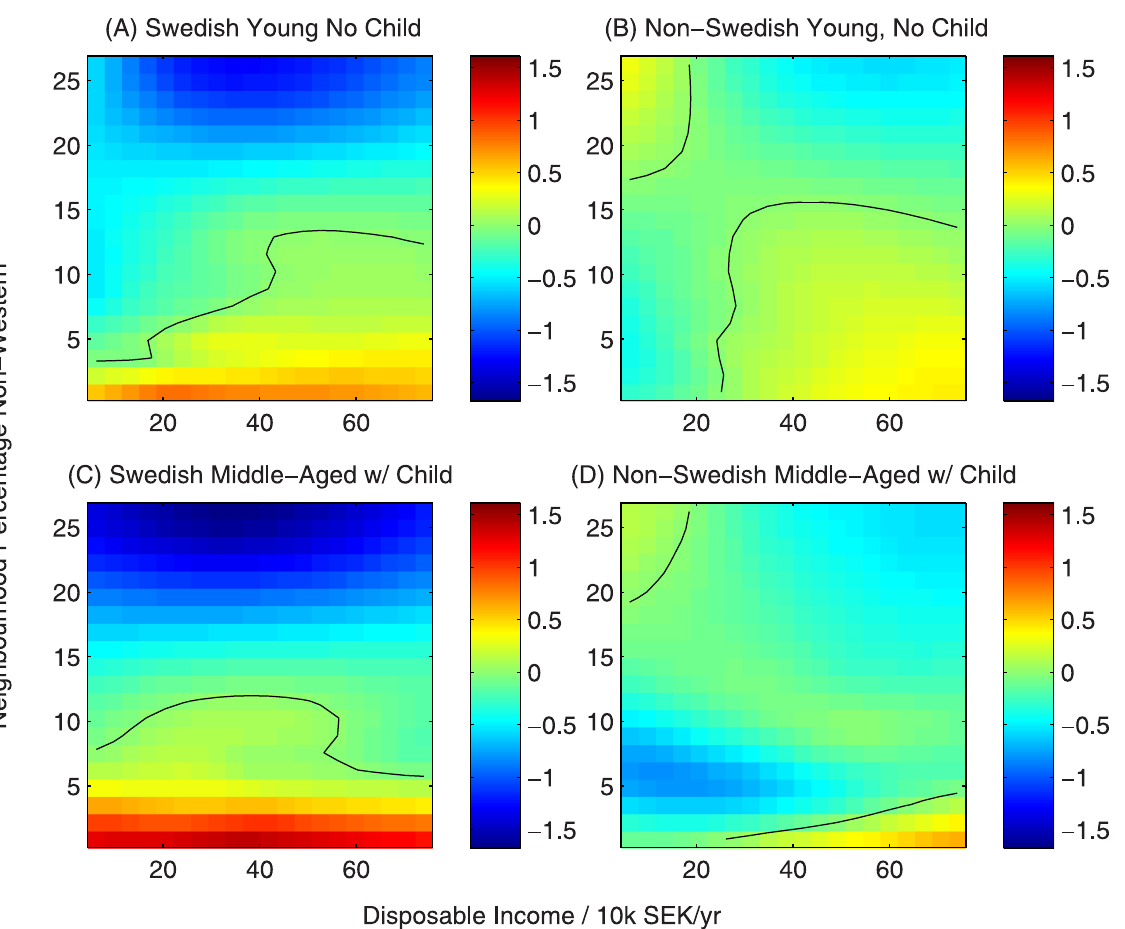
Fig 3. Utility function for neighbourhood share of non-western residents. Black contours represent a utility of zero, indicating no overall preference for or against neighbourhoods with this characteristic.